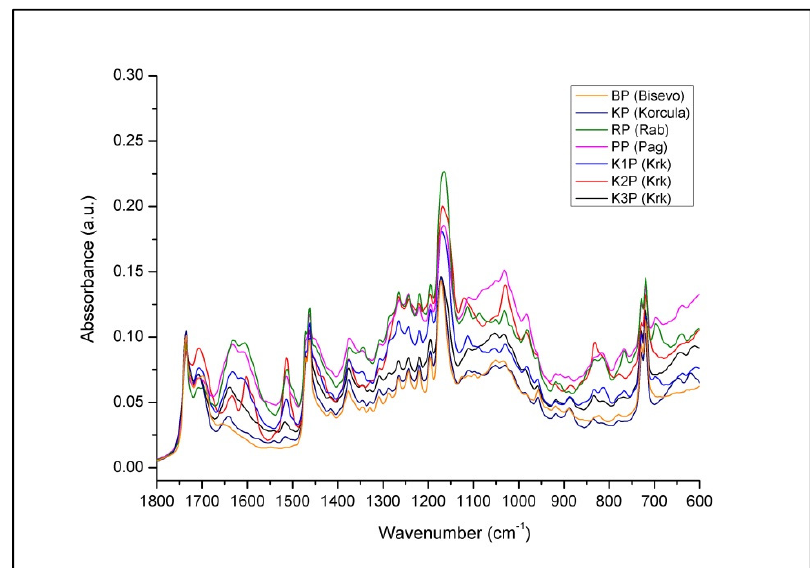
Figure 4. Overlaid average FTIR ATR spectrum of investigated propolis collected from five Adriatic Sea islands (Krk, Rab, Pag, Biševo and Kor č ula)—fingerprint region (1800–600 cm − 1 ) emphasizing comparative spectral variations.